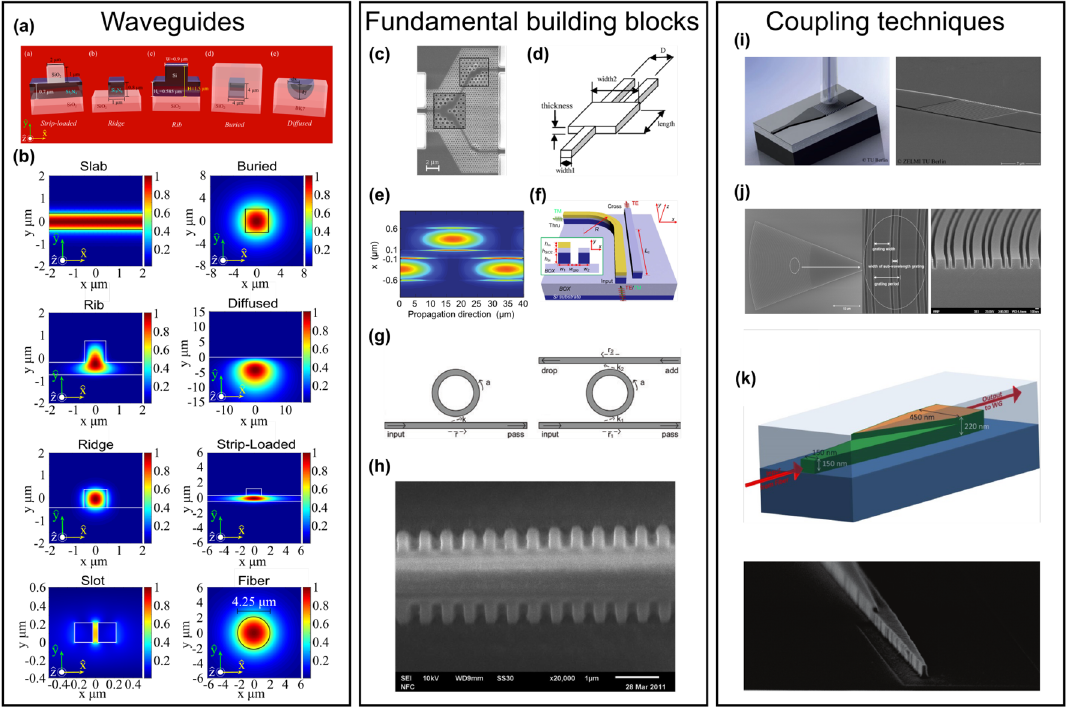
Figure 2: Key passive components in on-chip nanophotonics. (a) Rendered images of laterally confined common passive waveguide archi- tectures (reproduced from [1]). (b) Quasi-TE polarization colormaps of | E x ( x , y ) | , normalized to the maximum amplitude in monomode wave- guides (reproduced from [1]): slab, buried, rib, diffused, ridge, strip-loaded, slot waveguide, and an optical fi ber (reproduced from [1]). (c) Scanning electron micrograph (SEM) images of the fabricated photonic crystal waveguide (PhCW) splitter (reproduced from [29]). (d) The splitter schematic main parameters (reproduced from [30]). (e) Evolution fi eld propagation along the directional coupler (reproduced